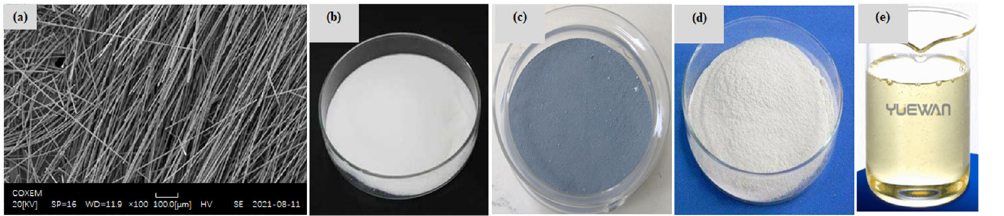
Figure 2. Morphology of ( a ) CFs, ( b ) water-reducing agent, ( c ) silica fume, ( d ) dispersant, and ( e ) defoamer (( a ) are from Ref. [28] while ( b – e ) are proposed by this paper).